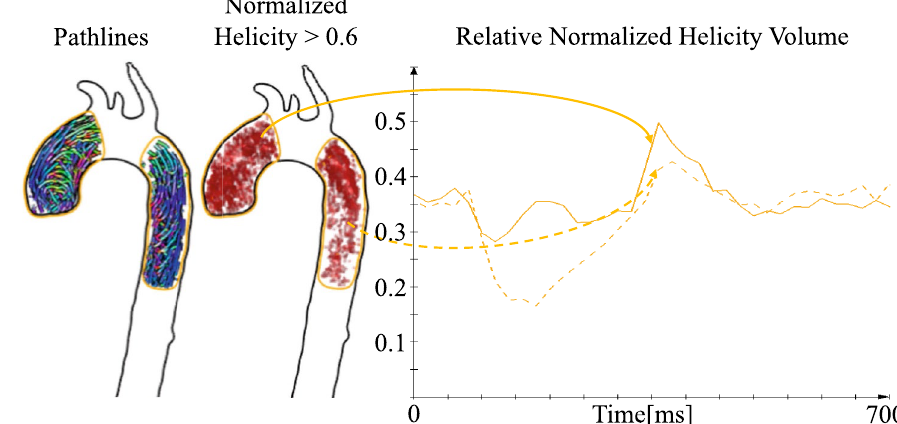
Figure 2. Time-resolved three-dimensional helicity in the thoracic aorta. Concept for the calculation of the relative thresholded normalized helicity for ascending (Asc) and descending aorta (Desc). The pathlines in the left part of this figure indicate helical flow patterns in the diastolic phase. The middle image shows the thresholded normalized helicity calculated for the corresponding timeframe. The diagram on the right demonstrates the resulting relative volumes VH s,t for the ascending and descending